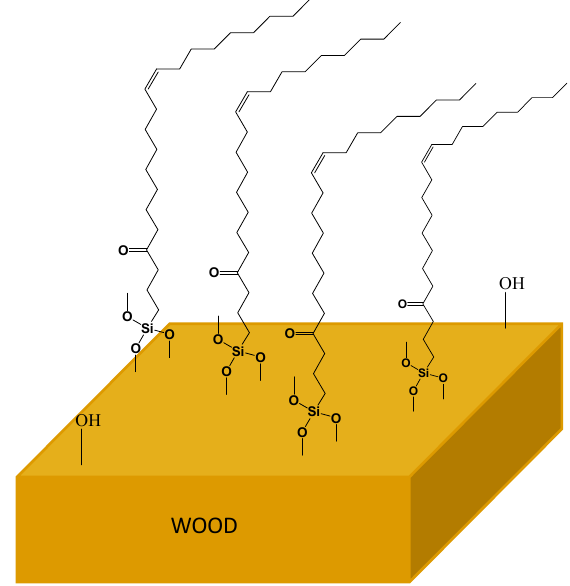
Figure 18. Schematic illustration of the covalent bonds formed between the silane groups of the vegetable oil-based coating and OH groups of wood. Adapted from [69], with permission from Springer Nature and Copyright Clearance Center, 2018.